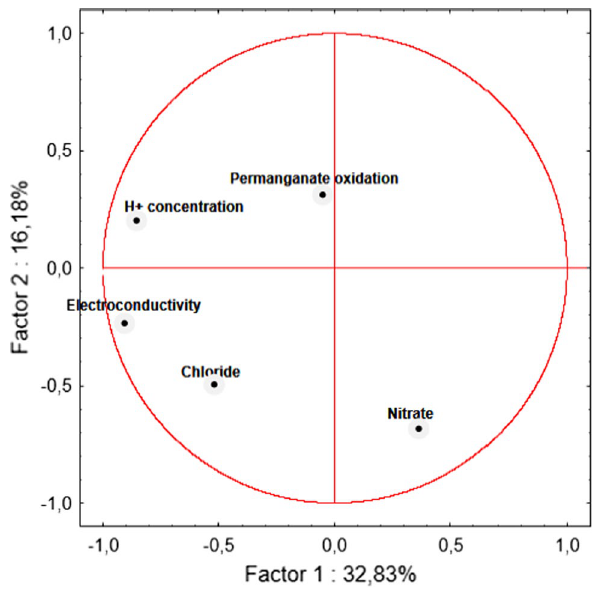
Fig. 3 Principle component analysis (PCA) for selected water quality parameters based on the six sampling locations (public supply